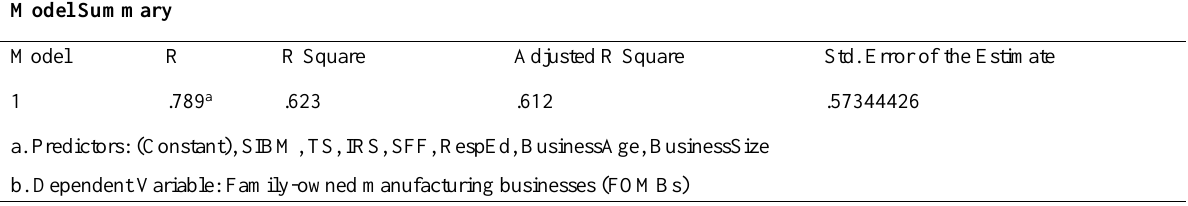
Table 4: Overall model fit results